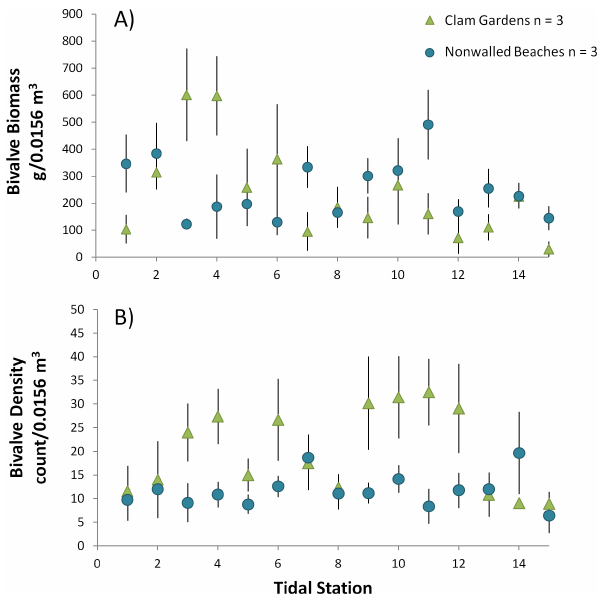
beach type or tidal station affected their species-specific densities (Table 2; intercept model of no effect for each species w 0.54, 0.30, respectively; Fig. 5C,D). Fig. 6 . Total bivalve (A) biomass and (B) density (± SE) as a function of tidal station in clam gardens (n = 3) and nonwalled beaches (n = 3) in Kwakshua Channel, British Columbia,